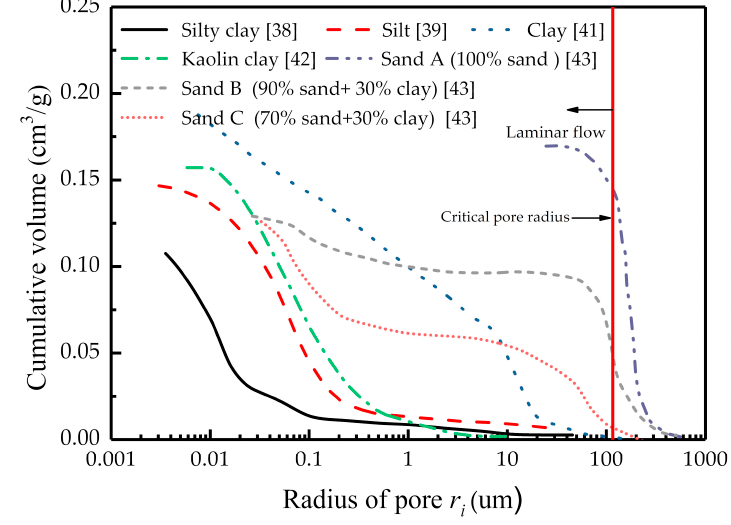
Figure 14. Pore size distribution of the soils.